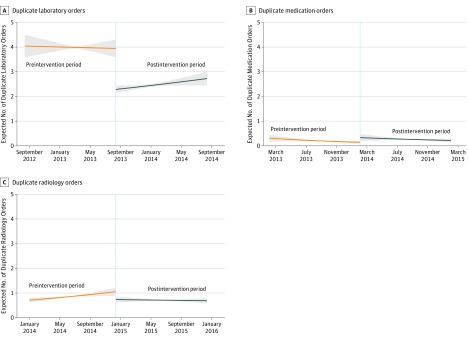
Interrupted Time Series of Unintentional Duplicate OrdersShaded areas indicate 95% CIs.